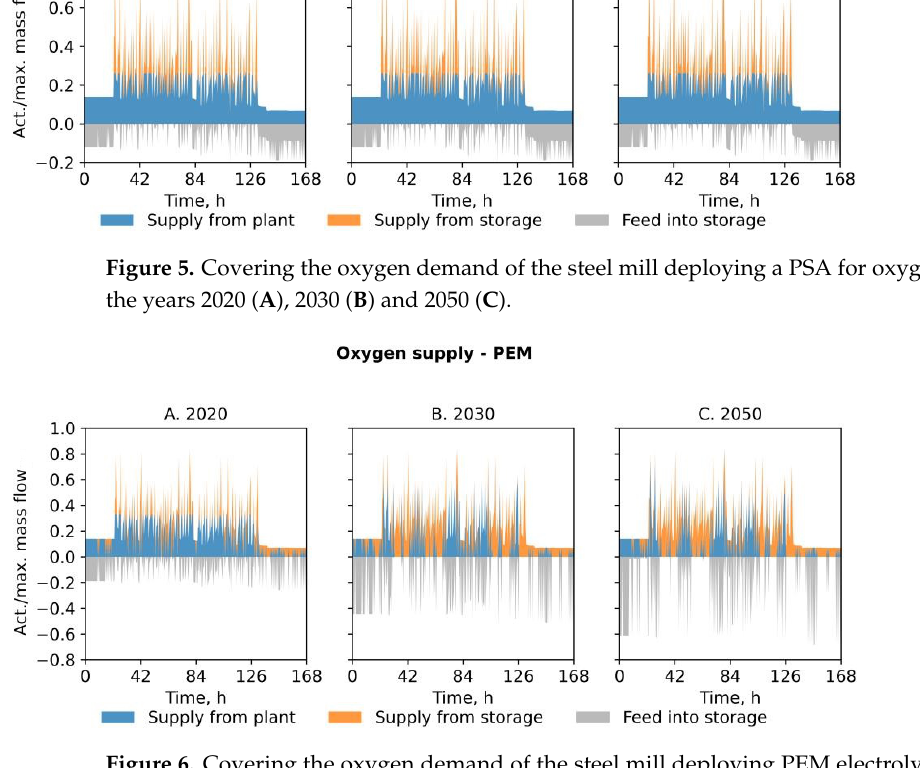
Figure 6. Covering the oxygen demand of the steel mill deploying PEM electrolysis for hydrogen